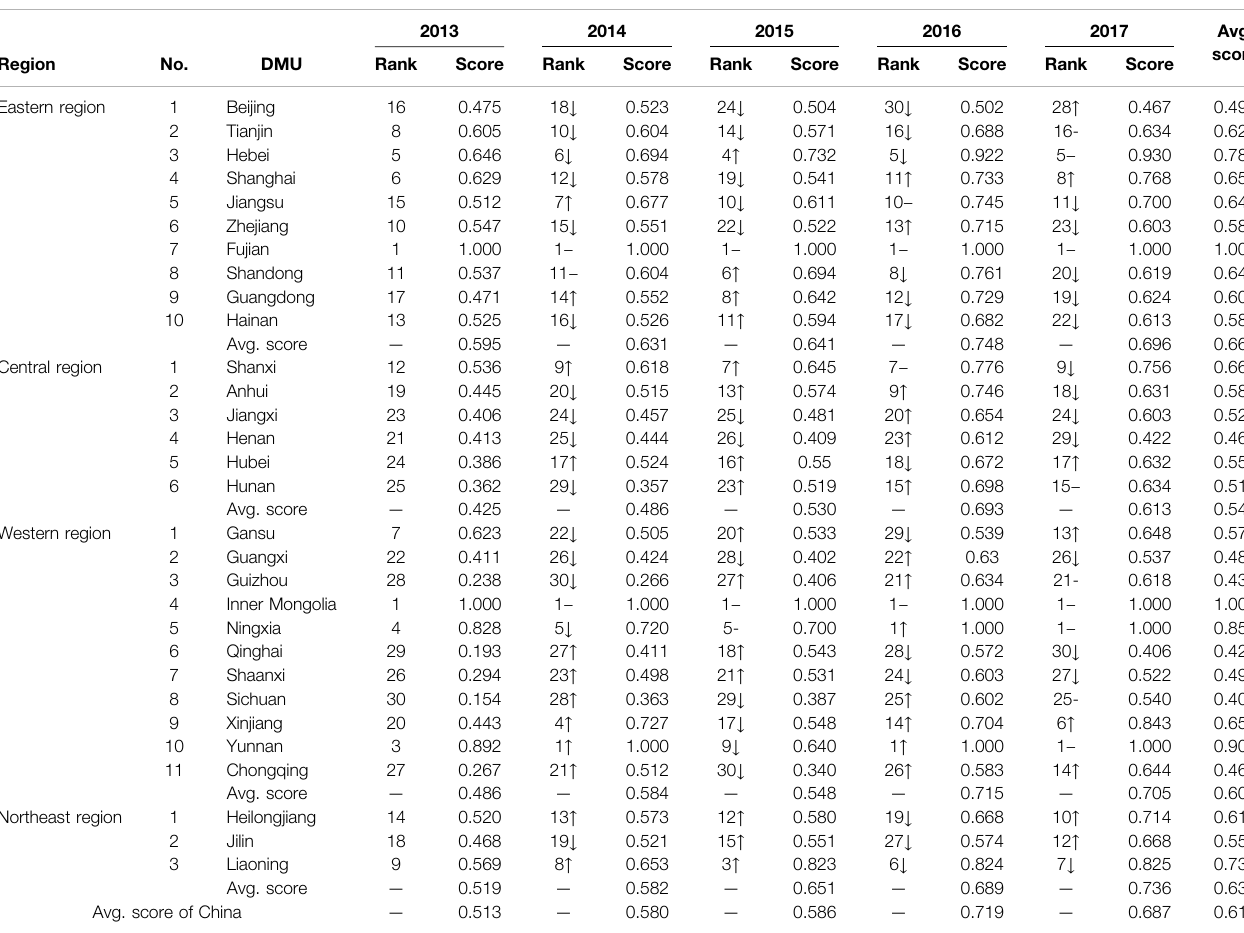
TABLE 4 | Overall ef fi ciency and